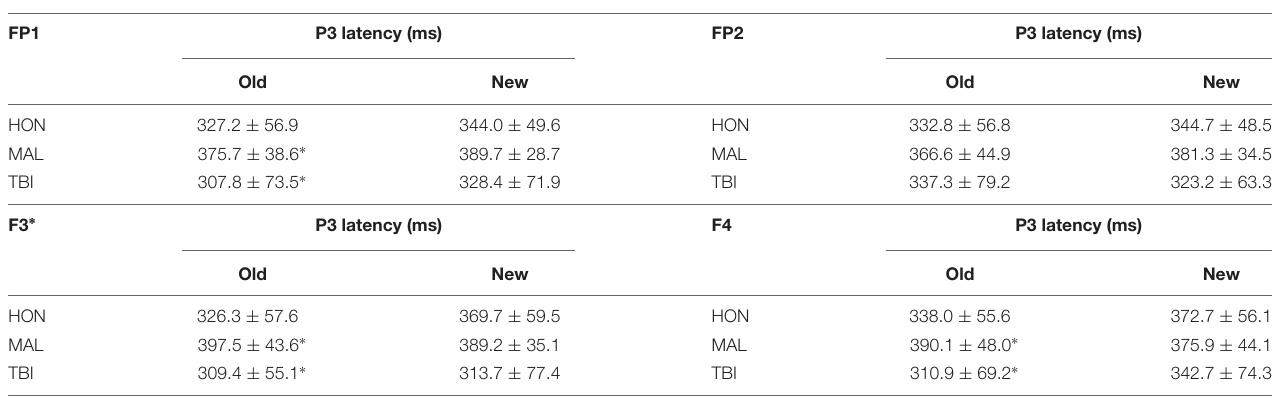
TABLE 1 | The average fractional latency (ms) of bilateral frontal electrode